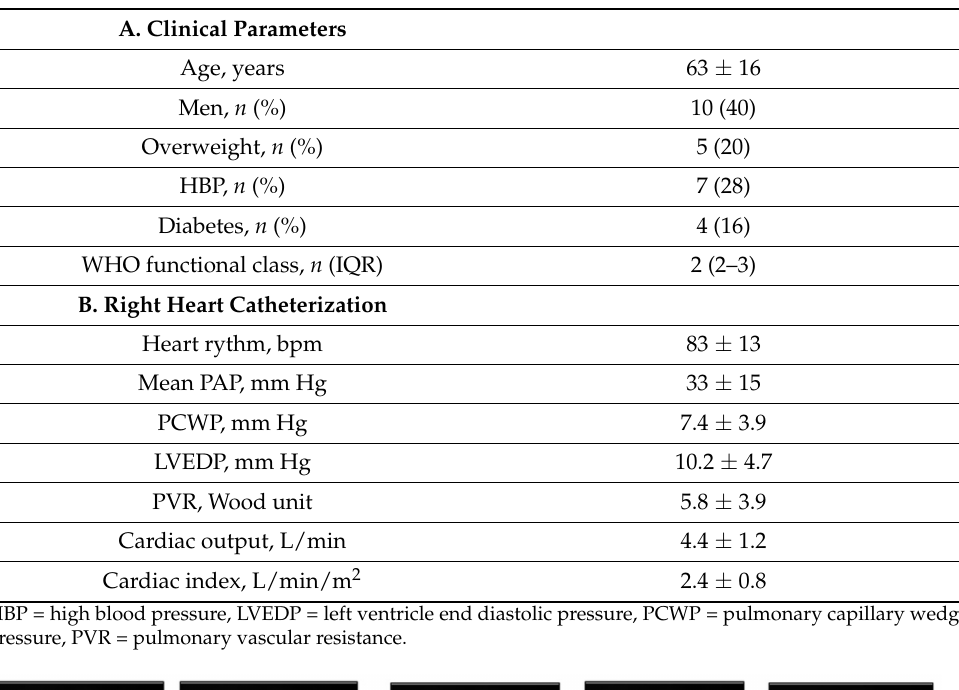
Table 1. Population characteristics.